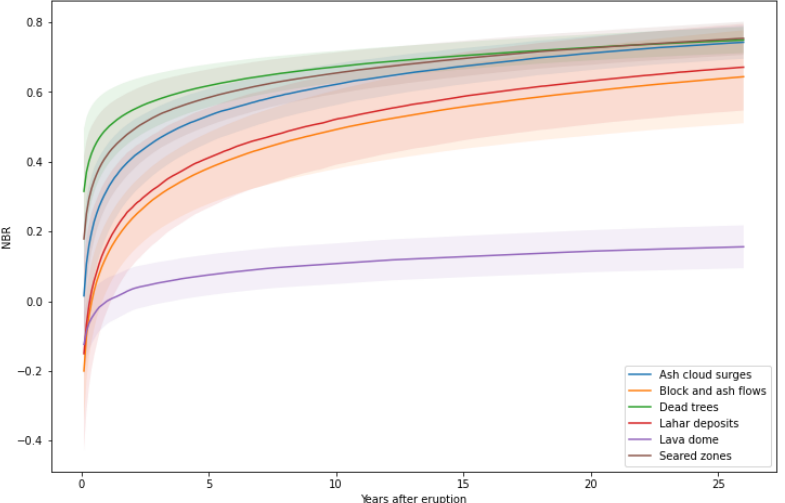
Figure 5. Average recovery curves from each disturbance type with one standard deviation repre- sented.